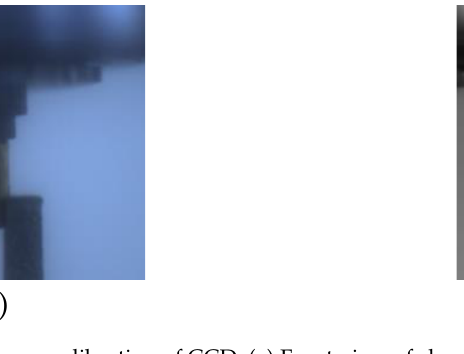
Figure 18. Parts ’ pose calibration of CCD. ( a ) Front view of sleeve after posture adjustment; ( b ) Left